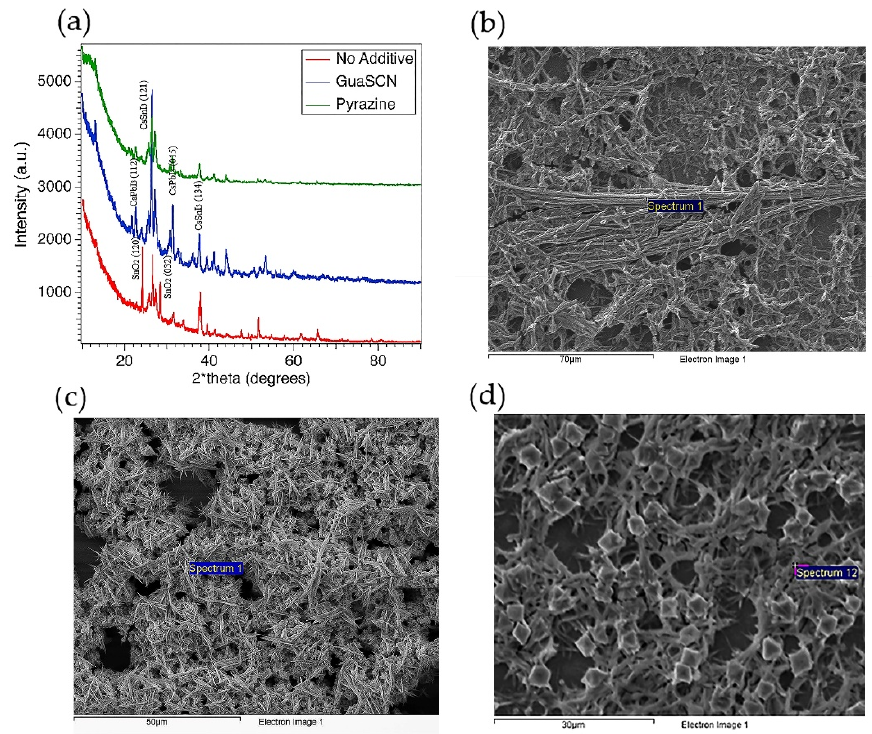
Figure 4. ( a ) XRD pattern for mixed Sn-Pb films with GuaSCN (blue), pyrazine (green), and no additive (red). Y-axis represents X-ray intensity in counts per second (CPS); top-down SEM image of GuaSCN film ( b ), pyrazine added films ( c ), and films with no additive ( d ).